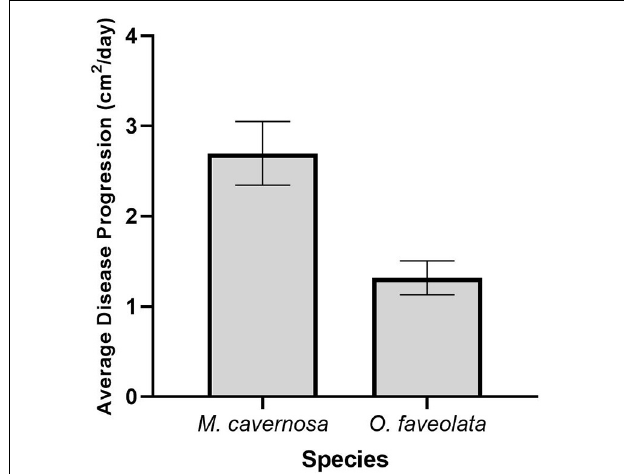
FIGURE 9 | Disease progression in M. cavernosa ( n = 9) and O. faveolata ( n = 14) recipient fragments. This figure represents the average disease progression rate for each species. Measurements were taken at the halfway point between initial disease appearance and mortality, on average 3.5